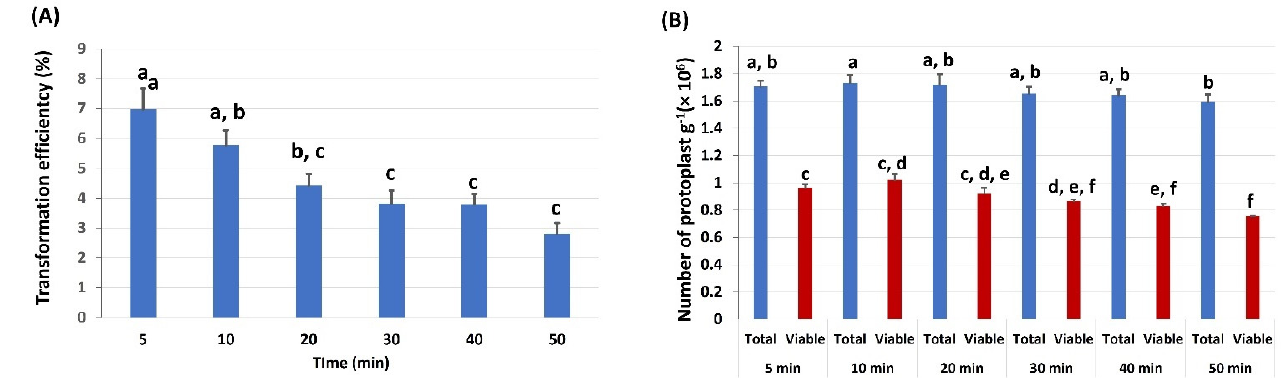
Figure 5. Effects of PEG incubation time on protoplast transfection: ( A ) the transformation efficiency of protoplasts cultivated with various PEG incubation times; ( B ) the effects of incubation time in PEG on protoplasts. The number of total protoplasts and viable protoplasts was counted after 24 h cultivation; 50% PEG solution was used in this experiment. Values represent means ± SE ( n = 7). The different letters indicate significant differences at p < 0.05.